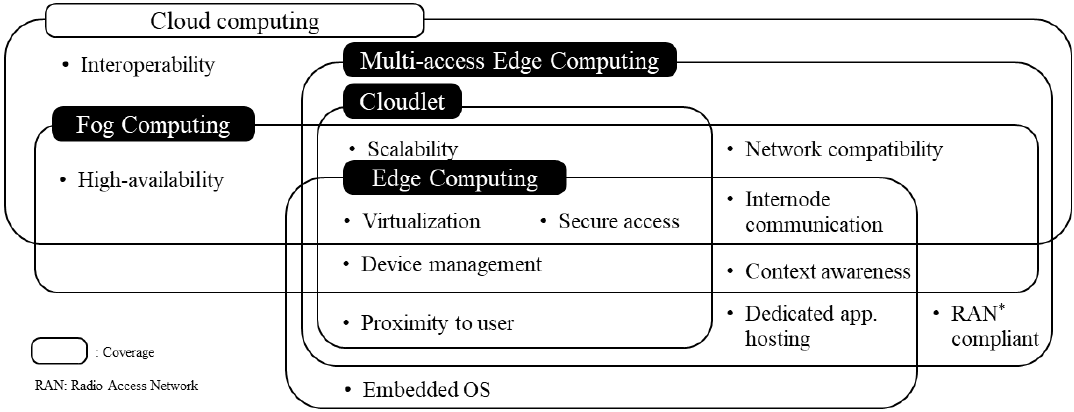
Figure 1. The coverage of key features among conventional cloud computing and edge-related technologies